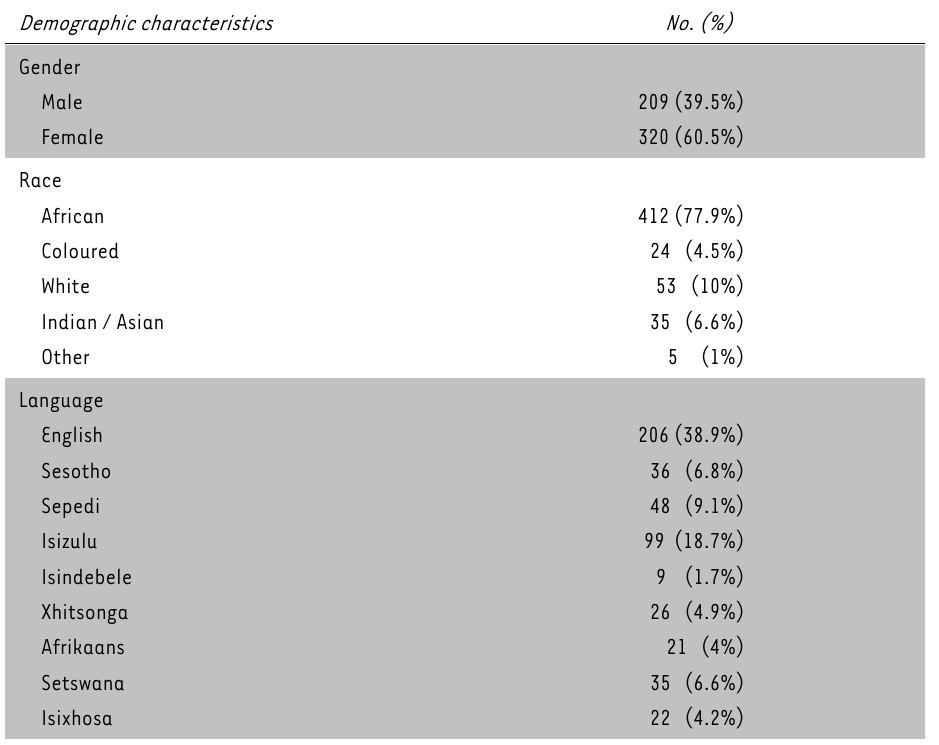
TABLE 1: Characteristics of respondents Demographic